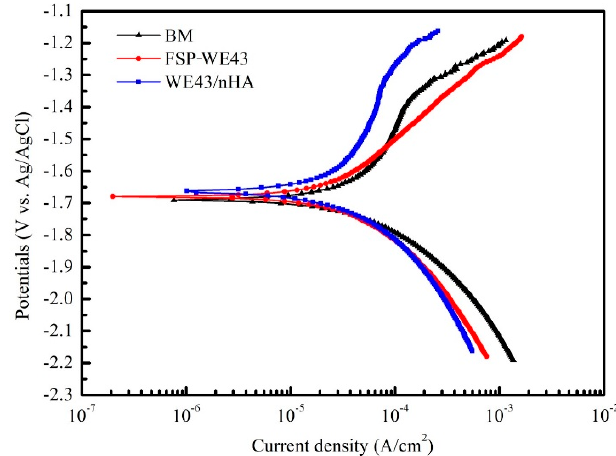
Figure 9. Potentiodynamic polarization curves of BM, FSP-WE43, and WE43 / nHA specimens in simulated body fluid (SBF).